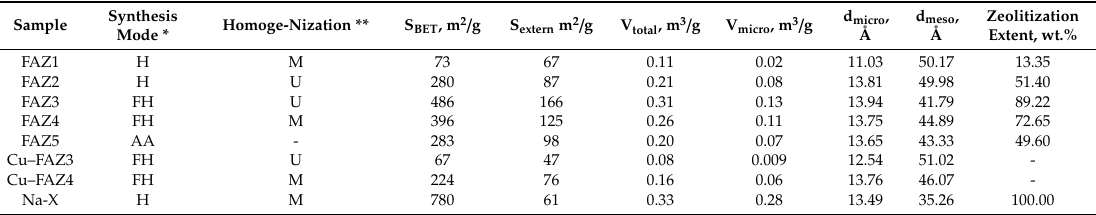
Table 2. Surface parameters and zeolitization extent of fly ash zelolites (FAZs), CuO-modified FAZs and a referent zeolite